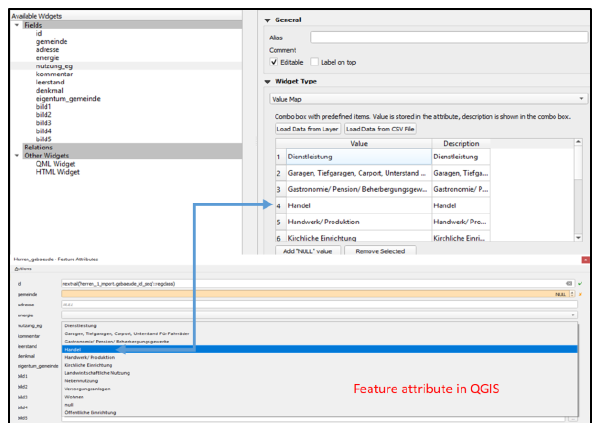
Figure 5 : Widget type configuration in attribute form for feature attribute in QGIS desktop.